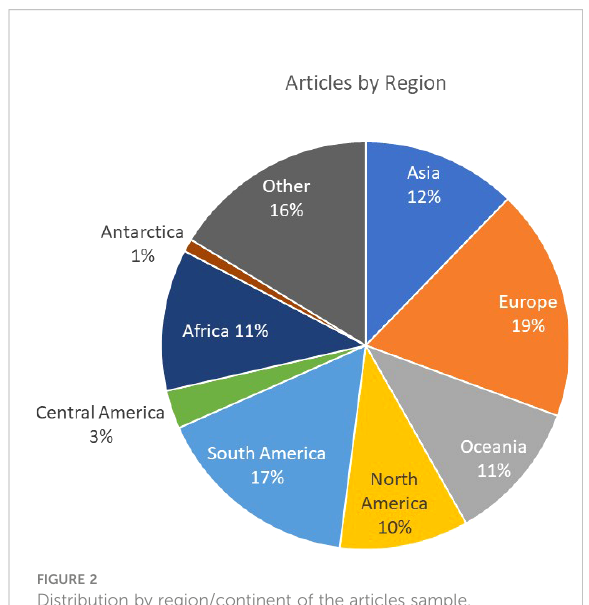
FIGURE 2 Distribution by region/continent of the articles sample.